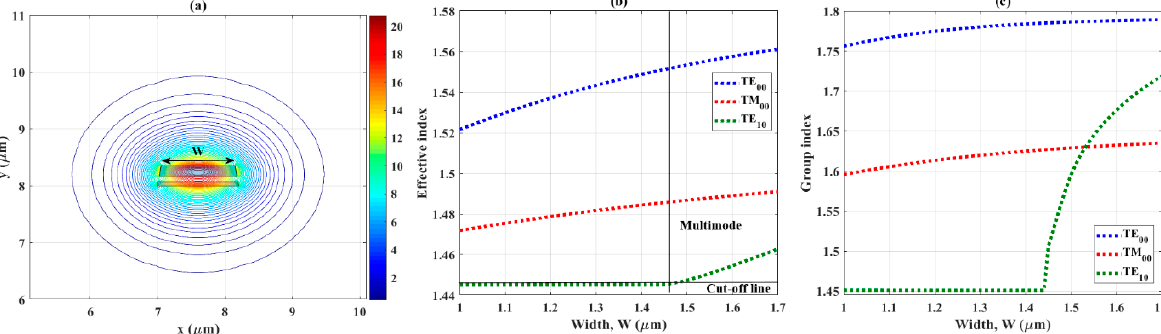
Figure 3a) to enable an assessment of the utility of the design rule. Each variant operates